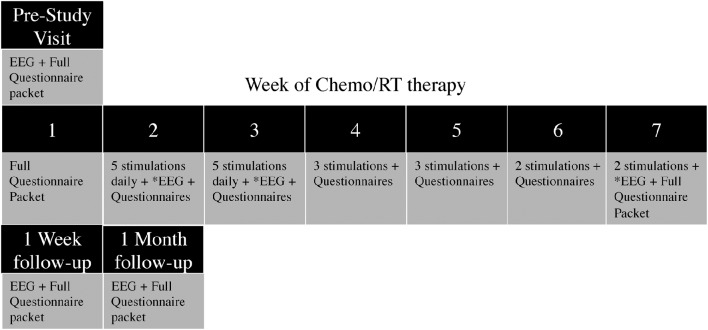
Study Protocol (* denotes simultaneous stimulation and EEG recording).